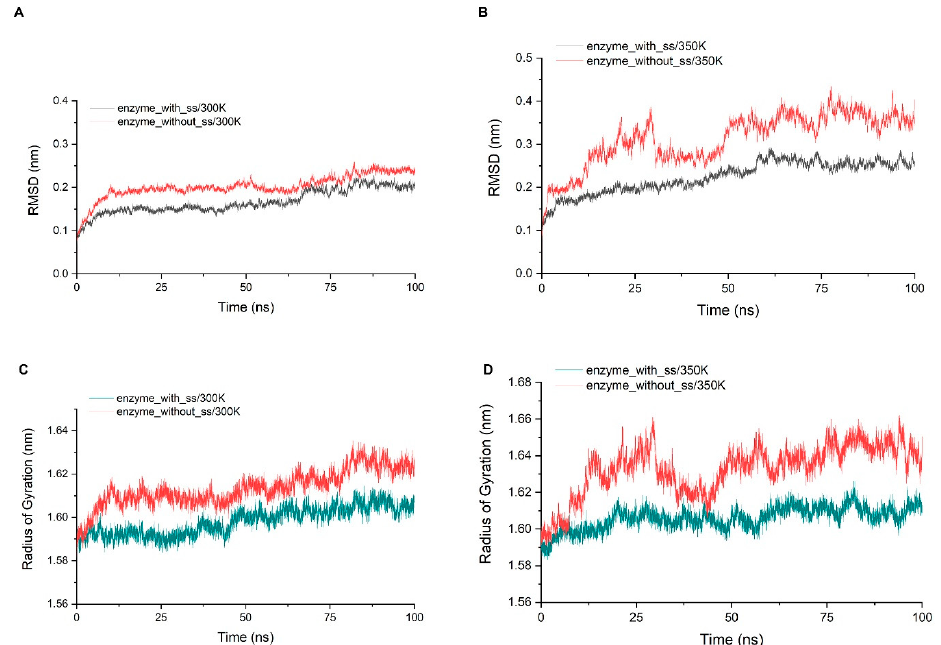
Figure 12. ( A , B ) show the comparison of the RMSD average values of three simulations at 300 K and 350 K between the chitosanase with and without disulfide bonds; ( C , D ) show the comparison of the average of the radius of gyration of three simulations at 300 K and 350 K between the chitosanase with and without disul fi de bonds.